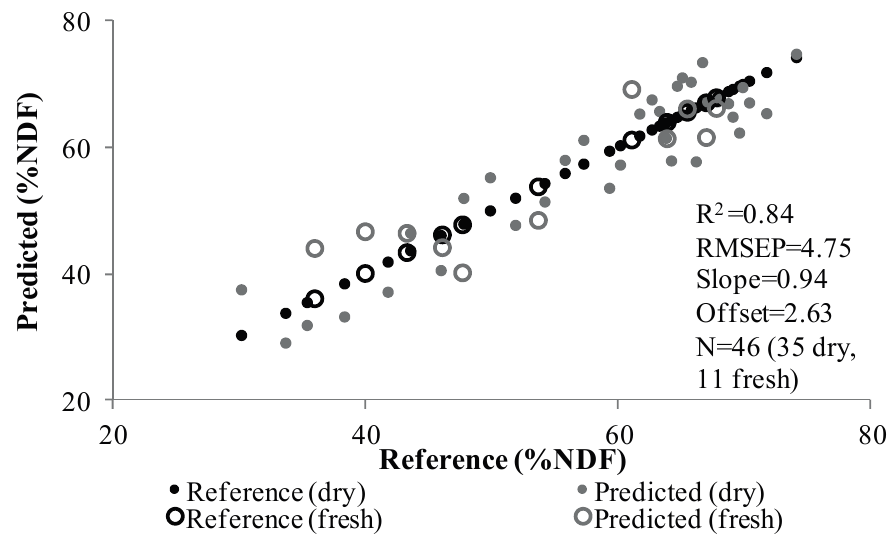
Figure 6. Neutral detergent fiber (NDF) distribution from predicted (external test data) vs